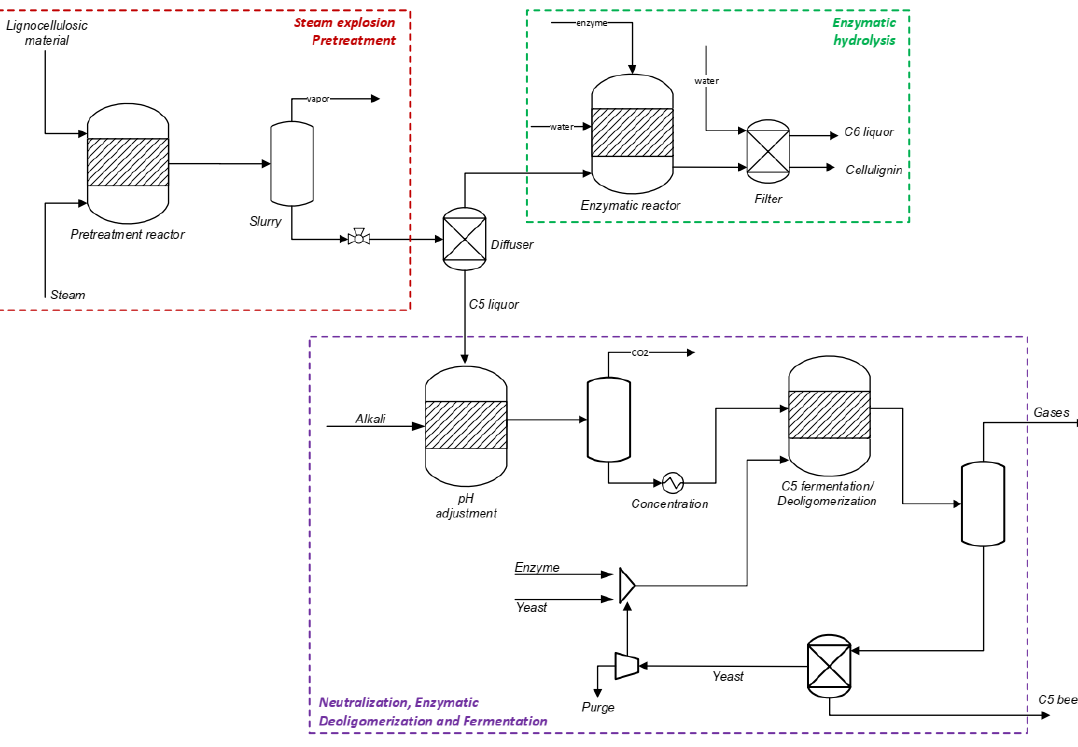
Figure A2. Process flow diagram of the second-generation ethanol production.